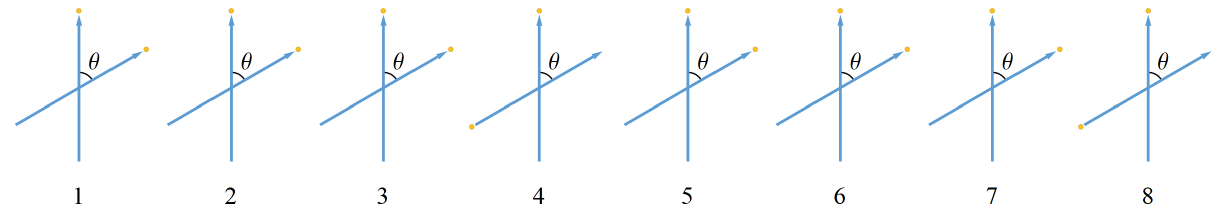
Figure 7: A spatiotemporal ensemble of 8 experimental trials for the spin triplet states showing Bob’s outcomes corresponding to Alice’s + 1 outcome when θ = 60 ◦ . Blue arrows depict SG magnet orientations and yellow dots depict the measurement outcomes. Spin angular momentum is not conserved in any given trial, because there are two di ff erent measurements being made, i.e., outcomes are in two di ff erent reference frames, but it is conserved on average for all 8 trials (six up outcomes and . Reproduced from Silberstein et al. [27]. two down outcomes average to cos (60 ◦ ) = 1 2